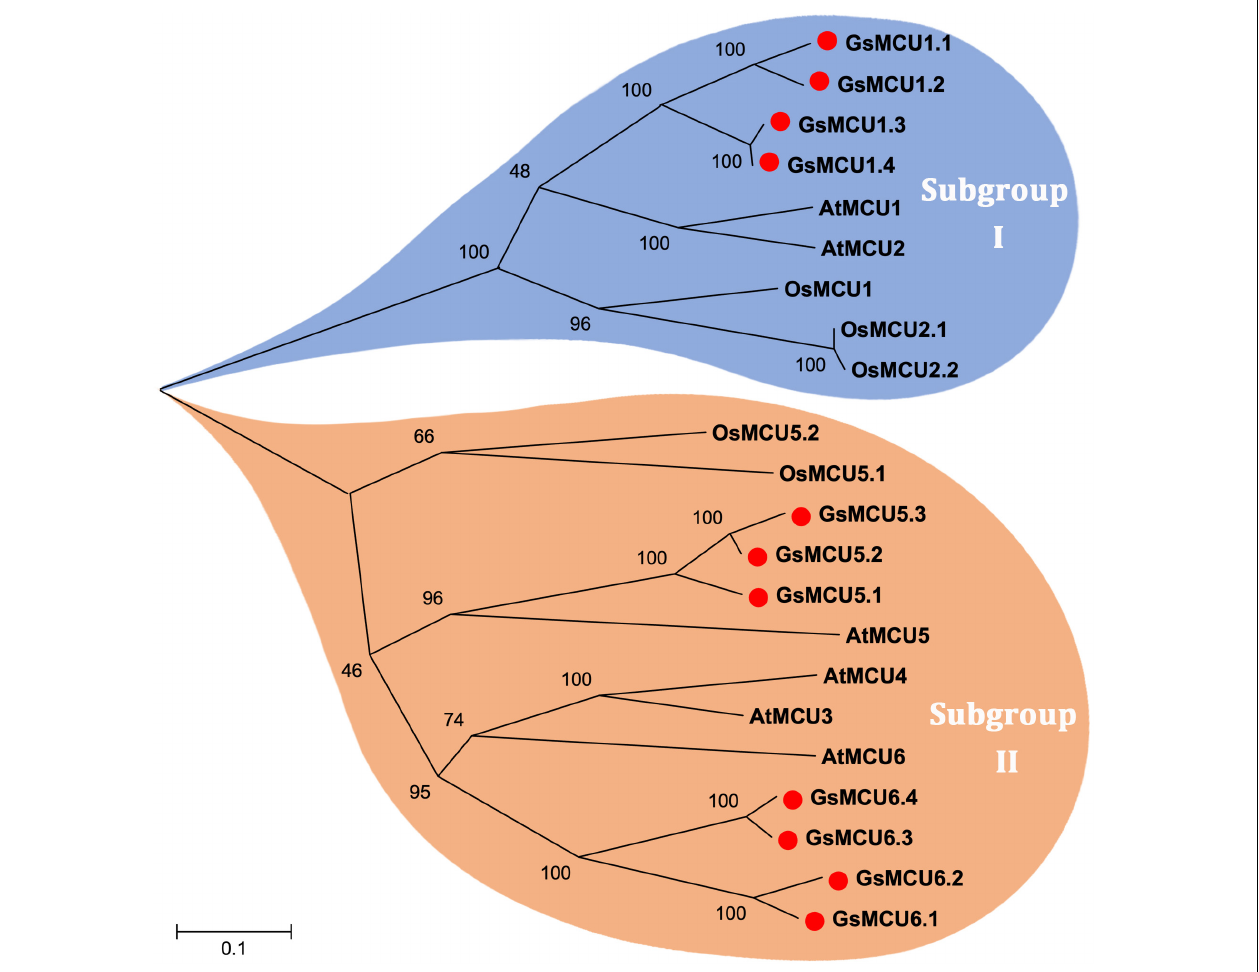
FIGURE 1 | Phylogenetic relationship of MCU proteins from Arabidopsis, rice and soybean. The phylogenetic tree was constructed using MEGA 5.10 software using the neighbor-joining method, and the bootstrap values were set at 1,000.